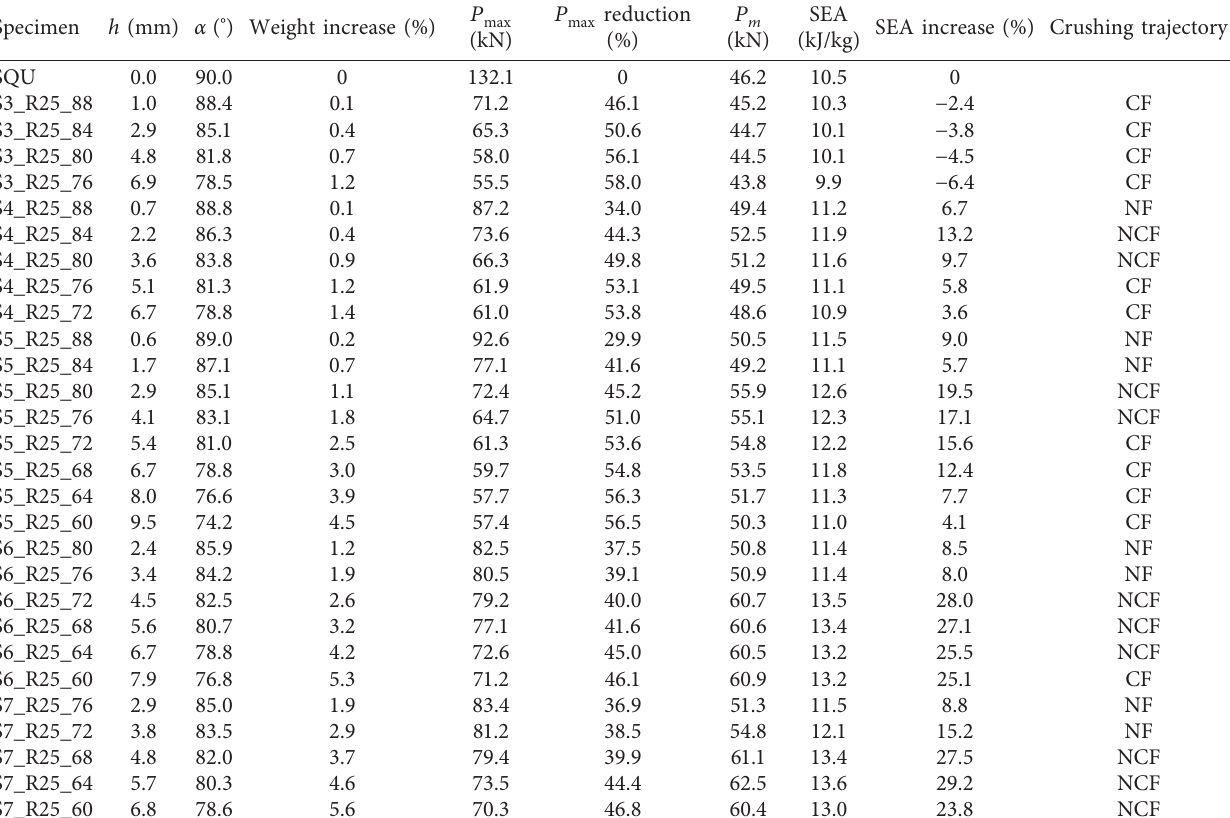
Table 1: Geometries and numerical results of square tubes with patterns for the analysis of parameters M and θ .